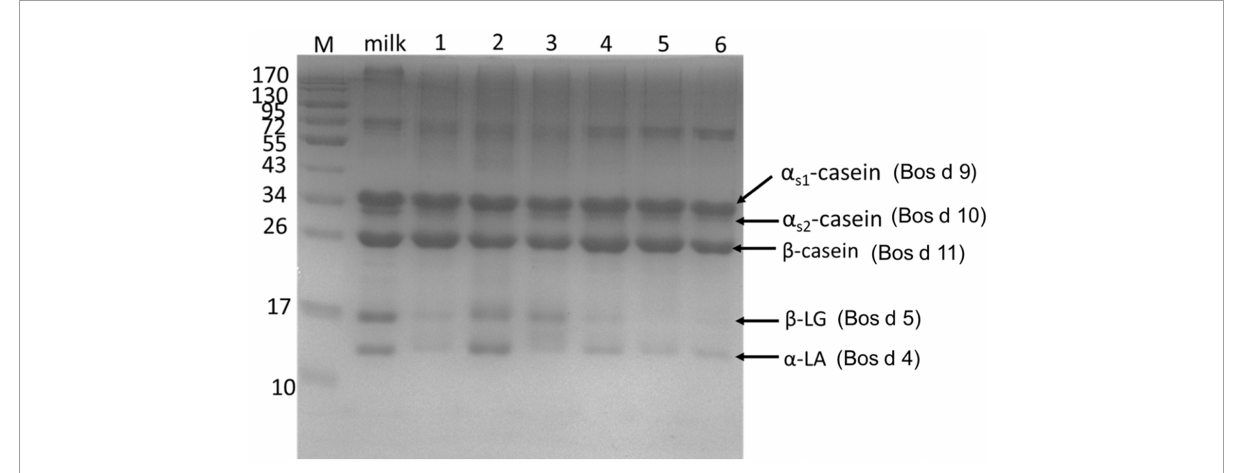
FIGURE1 SDS-PAGE showed the proteins profile of yogurts. Lane 1: GuMi yogurt; Lane 2: JSD yogurt; Lane 3: HR yogurt; Lane 4: HN yogurt; Lane 5: JA yogurt; Lane 6: HS yogurt. Lane M: prestained marker.